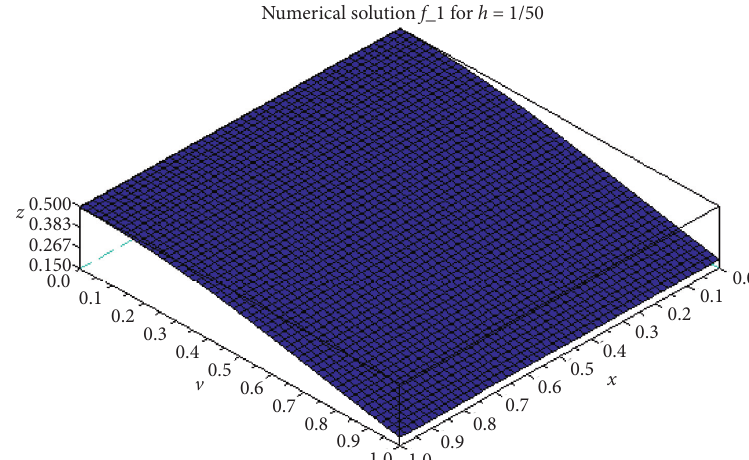
Figure 3: Numerical solution f 1/50